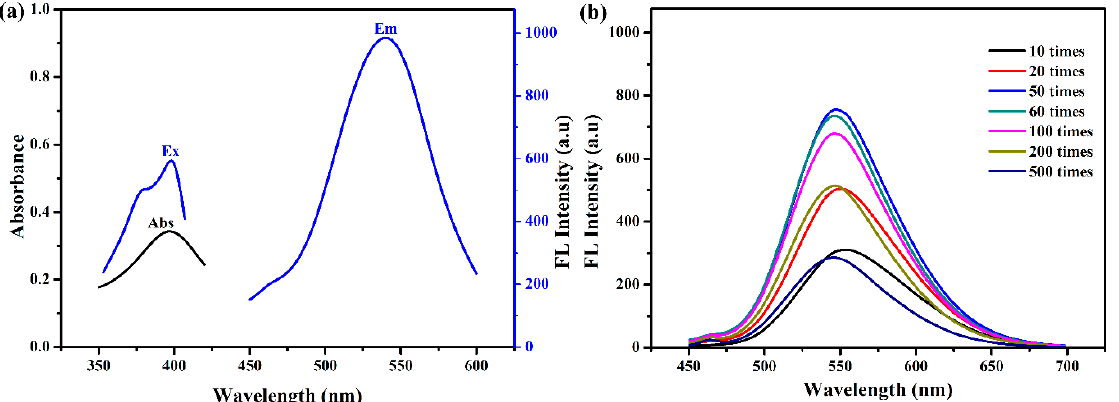
Figure 4. ( a ) UV–vis adsorption and fluorescence spectra of N-CQDs; ( b ) fluorescence intensity of N-CQD solutions.